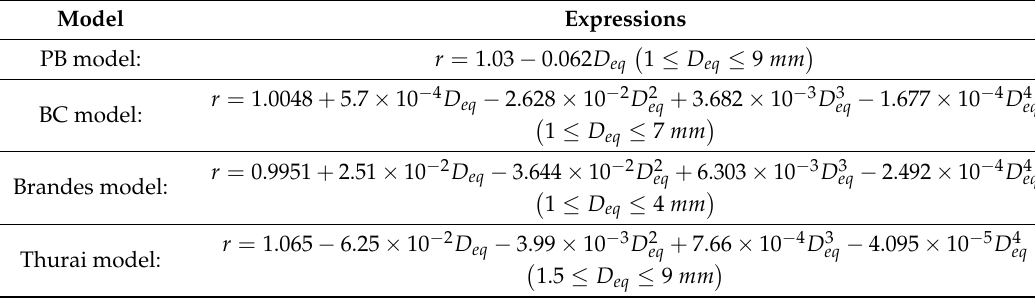
Table 1. Expressions for different raindrop shape-size